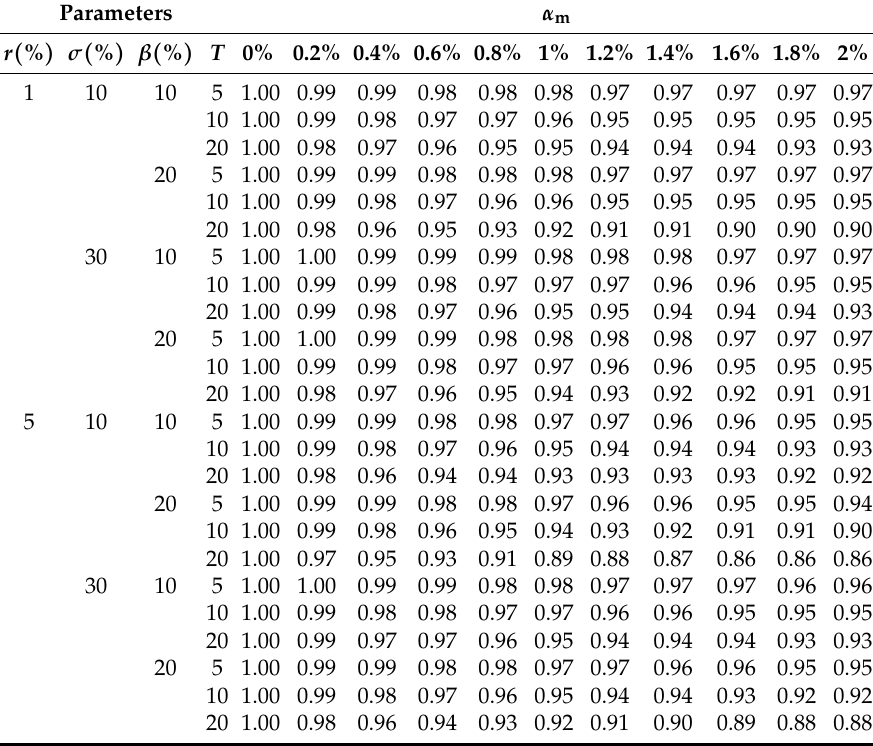
Table 4. Total value V ( 0, X ( 0 ) ; Γ V ) based on the policy value maximization strategy Γ V .